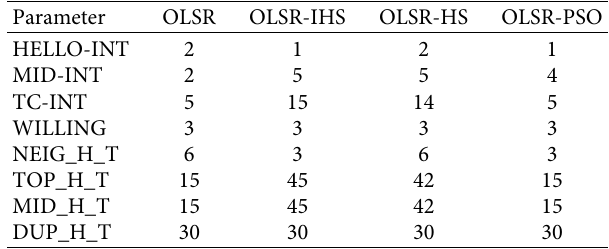
Table 4: Original OLSR and the obtained OLSR parameters using optimization methods.